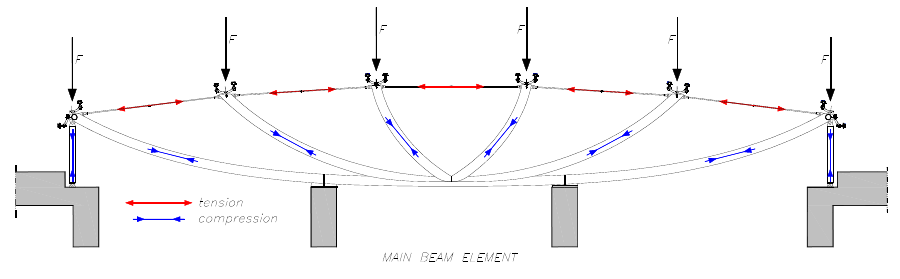
Figure 4: Structural behavior of main